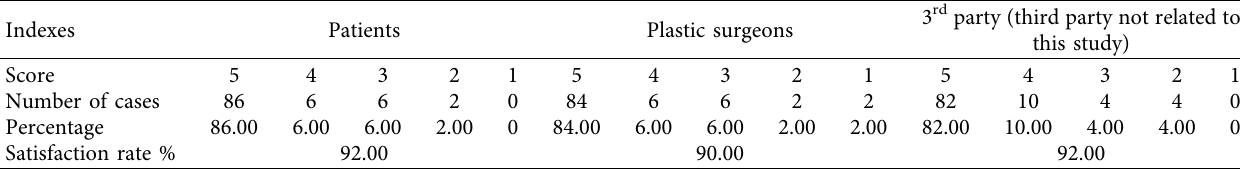
Table 3: Satisfaction evaluation of patients, plastic surgeons, and third parties 12 months after surgery.